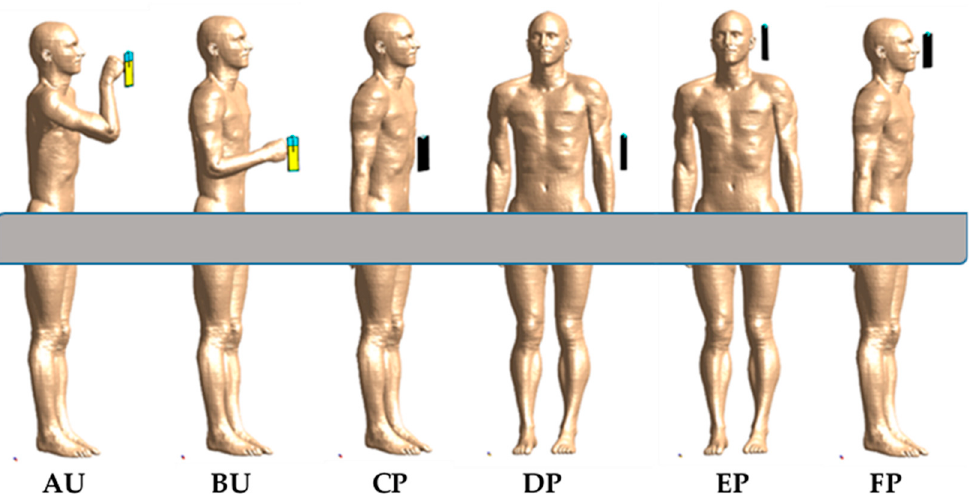
Figure 6. The exposure scenarios: (1) exposure of an operator grasping a MO-RFID reader (AU—in front of the face; BU—in front of the chest, (2) exposure of an individual approaching a RFID gun used as in AU or BU scenario (CP—in front of the chest; DP—at the side of the body, at the height of the chest; EP—at the side of the body, at the height of the head; FP—in front of the face). The anatomical numerical model of operator—Duke developed by the ITIS Foundation (over 300 tissues/organs: muscles, fat, bones, nervous tissues, heart, liver, skin, etc.).